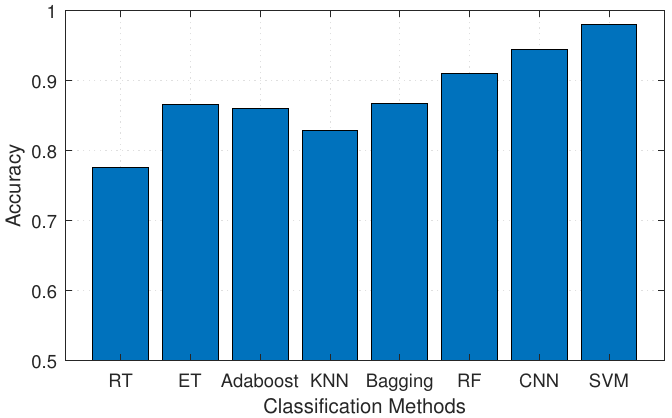
Figure 11. Comparison of recognition accuracy of different classification methods